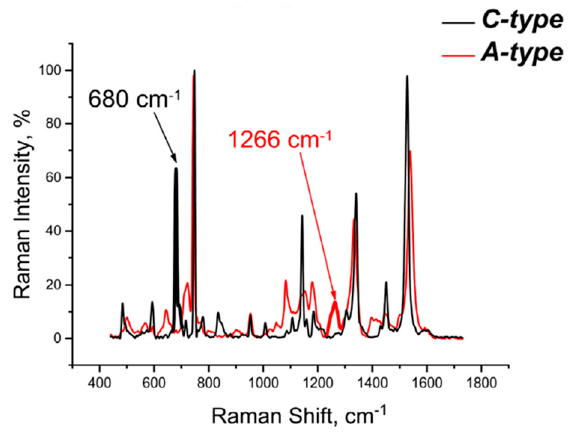
Figure 2. Raman spectra of writing inks based on: 1—phthalocyanine blue pigment (C-type); 2—alcohol-soluble phthalocyanineblue (A-type). All Raman spectra were recorded at 785-nm excitation. Table 2. Frequencies and shapes of vibrations in Raman spectra recorded for writing inks containing either alcohol-soluble phthalocyanineblue or phthalocyanine blue pigment (A-type or C-type, respectively) and literature data for the copper phthalocyanine molecule.